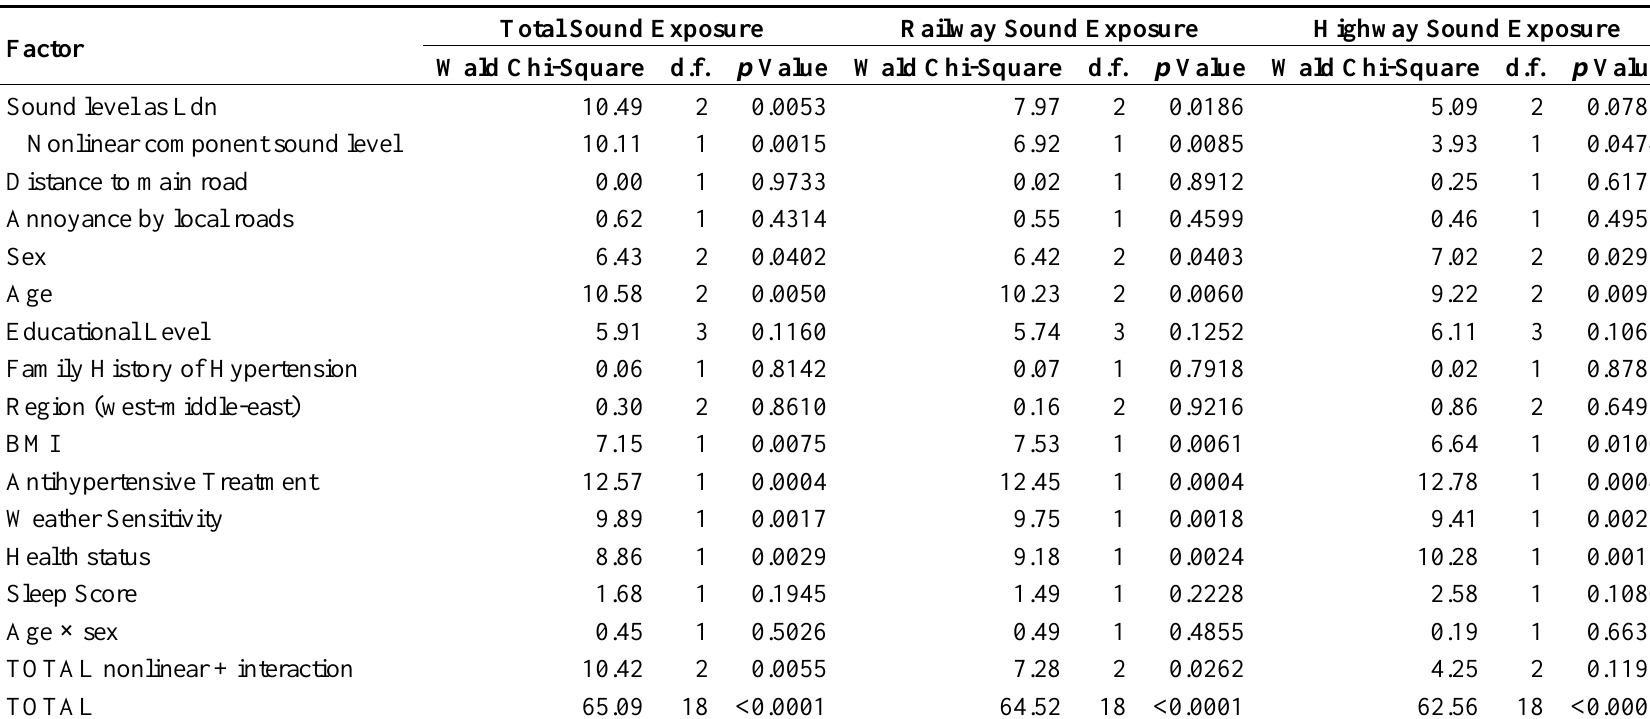
Table 4. Multiple logistic regression results for total, rail and highway sound exposure models with hypotension medication, including twelve covariates (N =